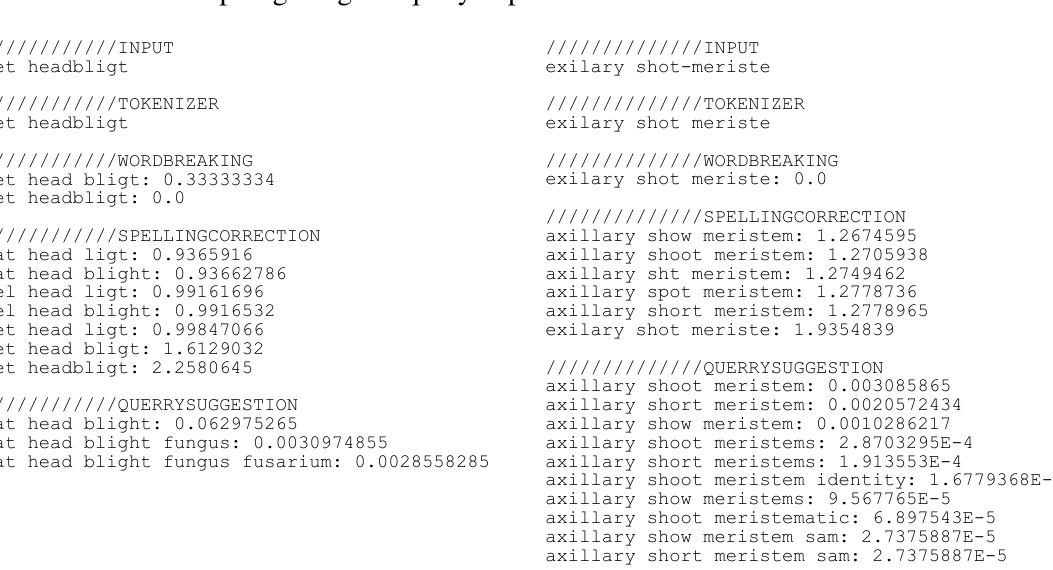
Figure 7: Results of each step in the suggestion workflow for the incorrect and not clearly